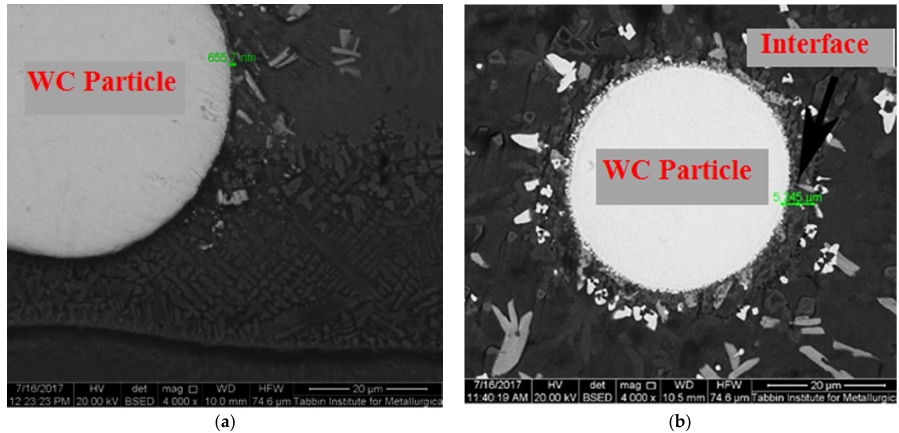
Figure 9. SEM of the interface of the WC particles in case of specific heat input of: ( a ) 18 J·mm − 2 ; and ( b ) 59.5 J·mm − 2 .